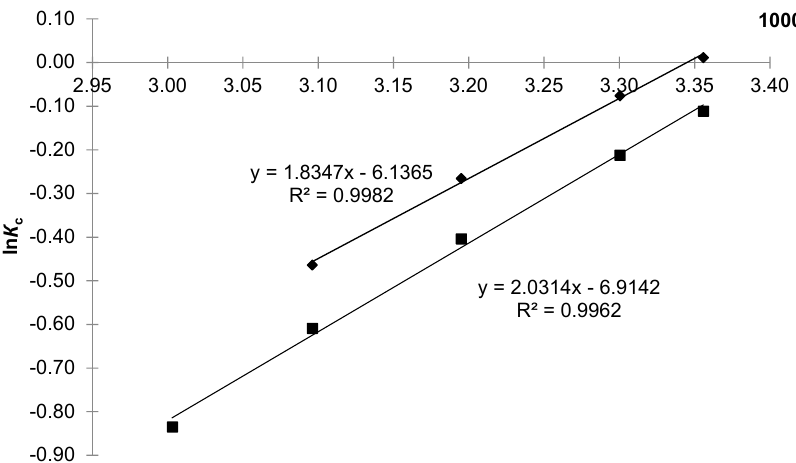
Figure 1. The influence of the reaction temperature on the equilibrium constant in the reactions of 2,3-BD with MEK ( ■ ) and in the reactions of 1,2-PD with acetone ( ♦ ).